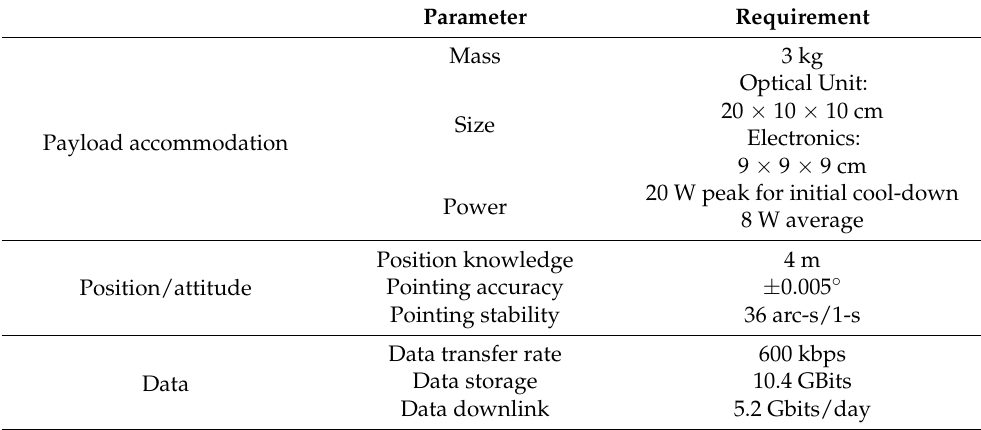
Table 2. Spacecraft accommodation.